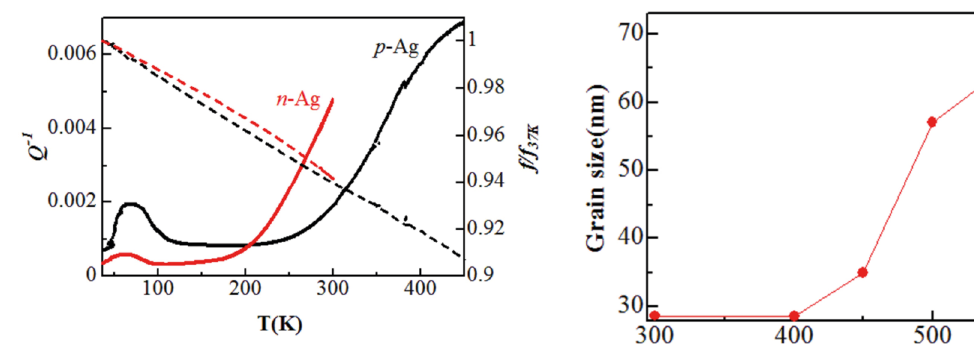
Figure 1. Temperature changes in internal friction ( Q −1 , red solid line) and resonant frequency ( f , red dashed line) of n -Ag. The data of internal friction (black solid line) and resonant frequency (black dashed line) of p -Ag are also depicted. The frequency normalized by the value at 37 K is shown in the figure, where f ~300 Hz and that of p -Ag is ~1200 Hz.